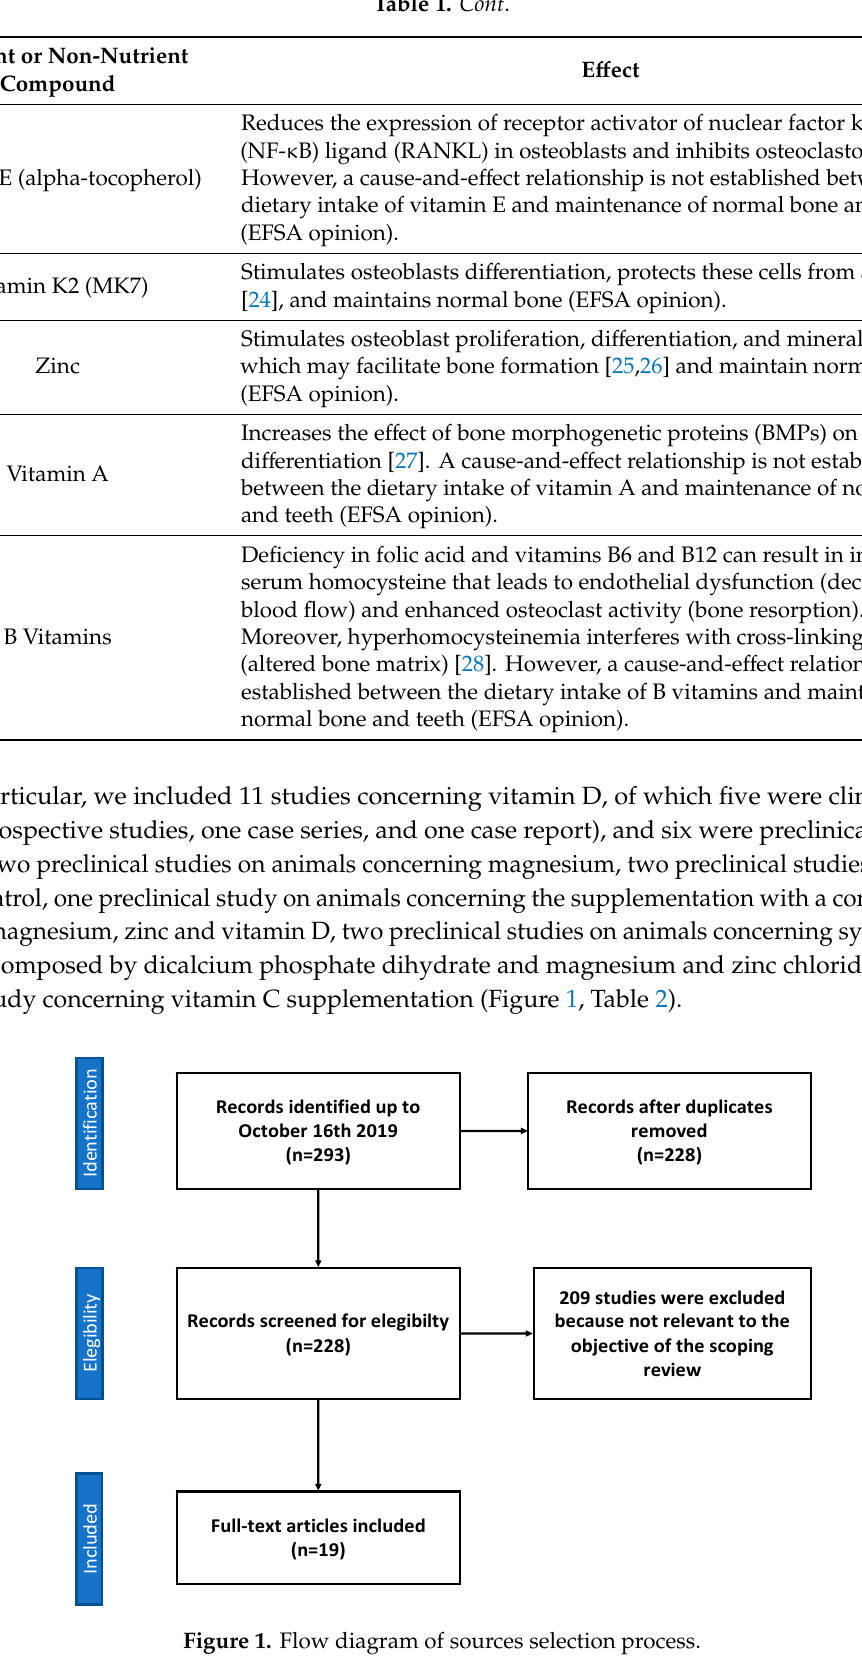
Figure 1. Flow diagram of sources selection process.